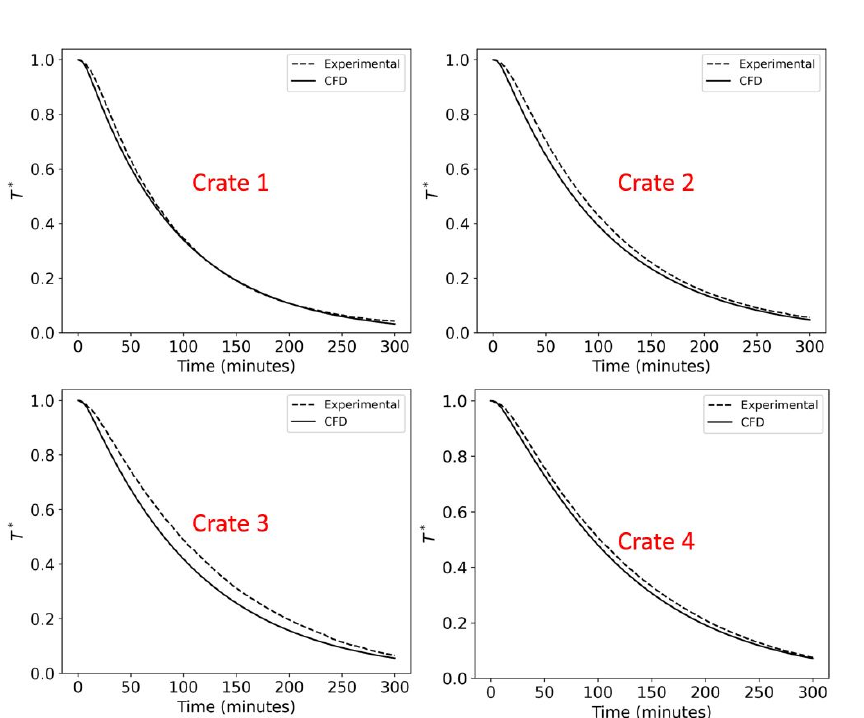
Figure 7. Comparison between the average experimental temperature measurements with respect to time and the average corresponding temperatures obtained numerically for the products in individual crates (crate B).